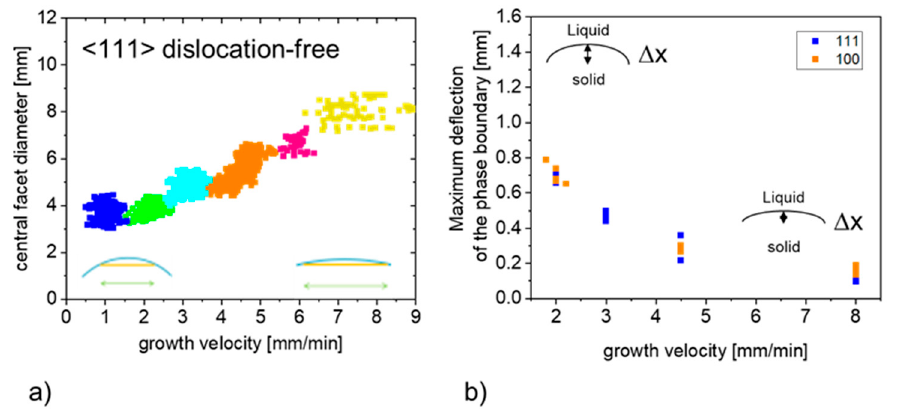
Figure 6. ( a ) Diameter d of the central facet as a function of the growth velocity for dislocation-free <111> crystals grown by the FZ technique; ( b ) interface deflection as a function of the growth velocity for dislocation-free <100> and <111> crystals grown by the FZ technique. In the case of the <100> crystal, the interface deflection was directly determined from the microscope images, whereas for the <111> crystals, the deflection of the melting isotherm T m is shown, which was obtained by the extrapolation of the interface shape from the rough interface in the outer crystal area to the inner area where the central facet occurs.